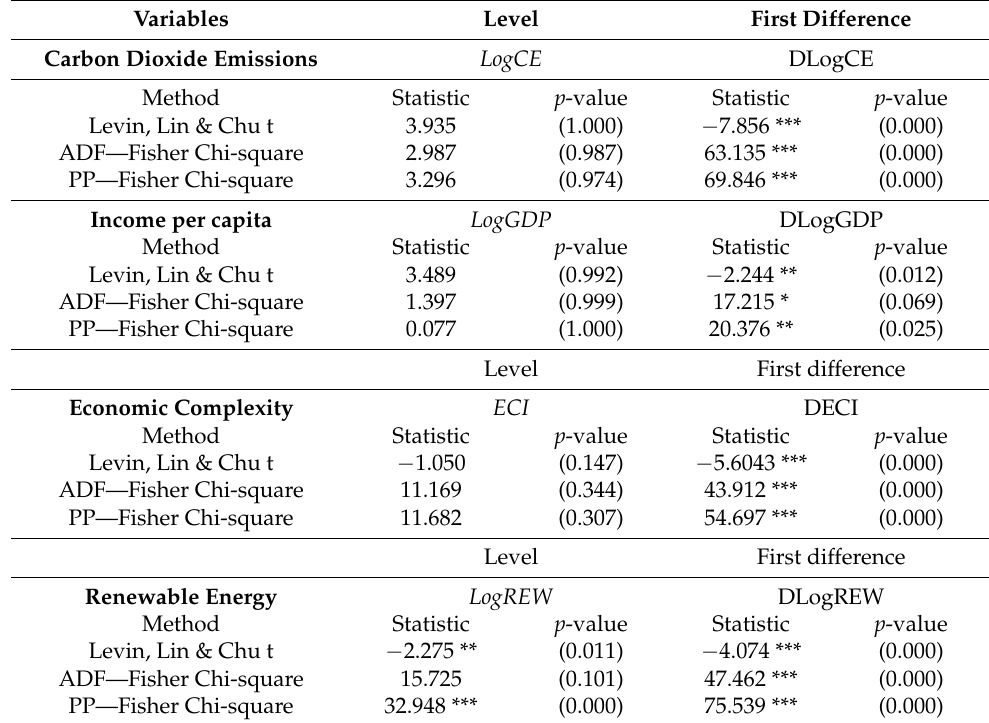
Table 3. Panel Unit Root Test.